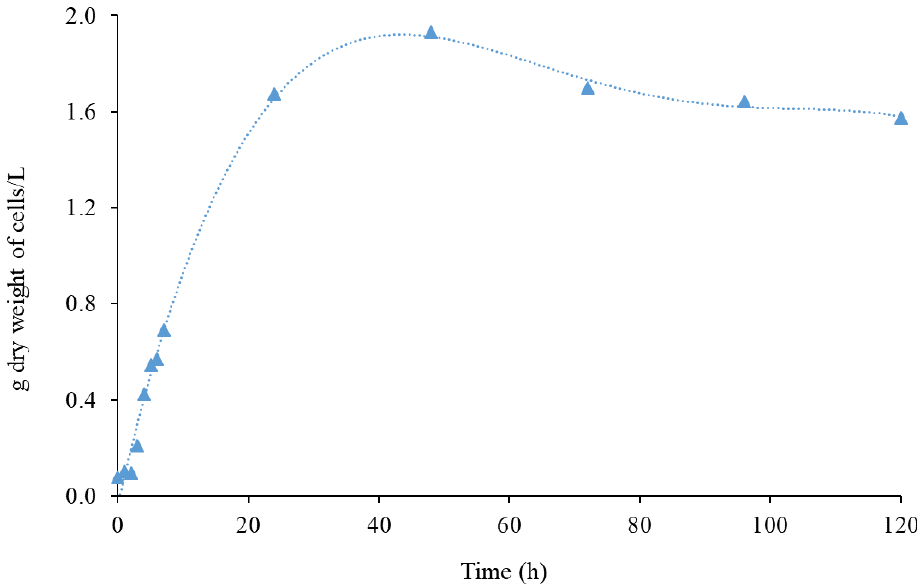
Figure 5. Clostridium carboxidivorans growth during syngas fermentation in ATCC® 2713 medium with 0.15% ( v/v ) Tween® 80 in stirred tank bioreactor.